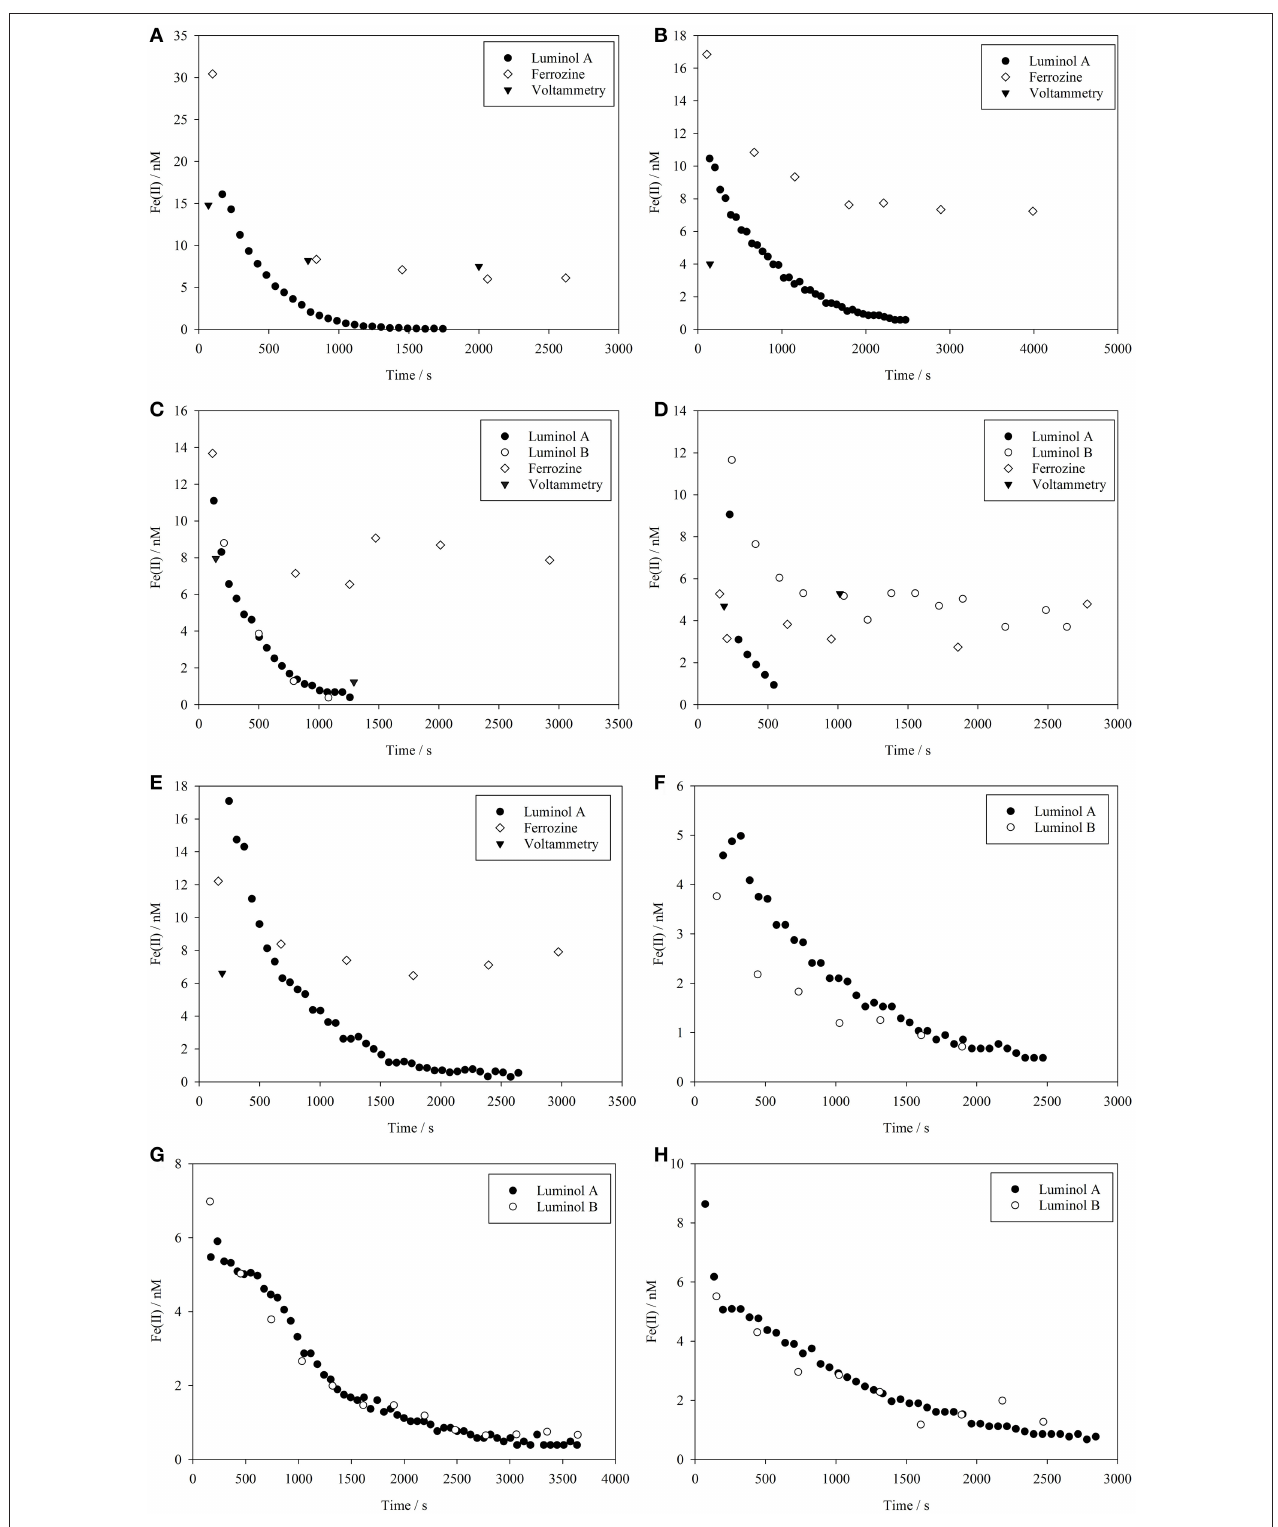
FIGURE 1 | Fe(II) concentrations measured using multiple methods during a series of eight method comparison experiments where Fe(II) was spiked into coastal seawater at t = 0. (A–H) Correspond to experiments 1–8 as per Tables 1 and 2 .